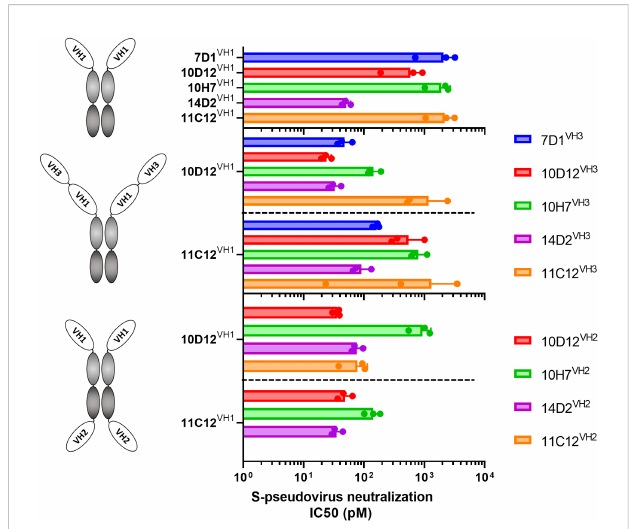
FIGURE 2 Neutralization potency of SARS-CoV-2 S-pseudotyped virus by bi- and tetravalent HCAbs. SARS-CoV-2 (Wuhan-Hu-1) pseudovirus neutralization potency (IC50 titers) on VeroE6 cells of the bivalent HCAbs (top panel), and the tetravalent HCAb designs with two VH domains at the N-terminal end of the Fc region (middle panel) or with two VH domains at opposite sides of the Fc region (low panel). Error bars indicate SD between three independent replicates, and neutralization curves are provided in Supplementary Figure